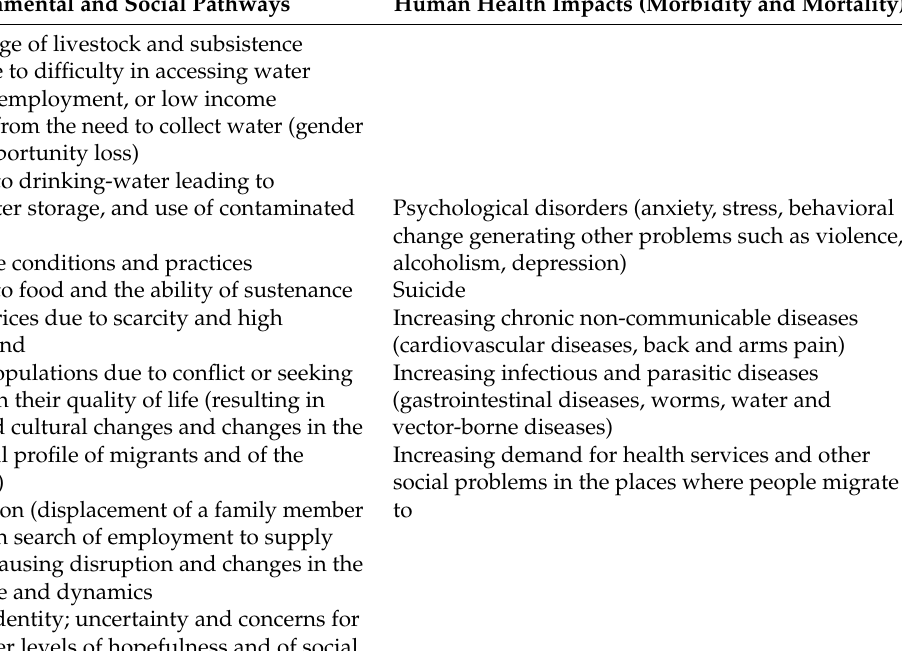
Table 2. Pathways and main health impacts from social, economic and health care system mediating factors. Mediating